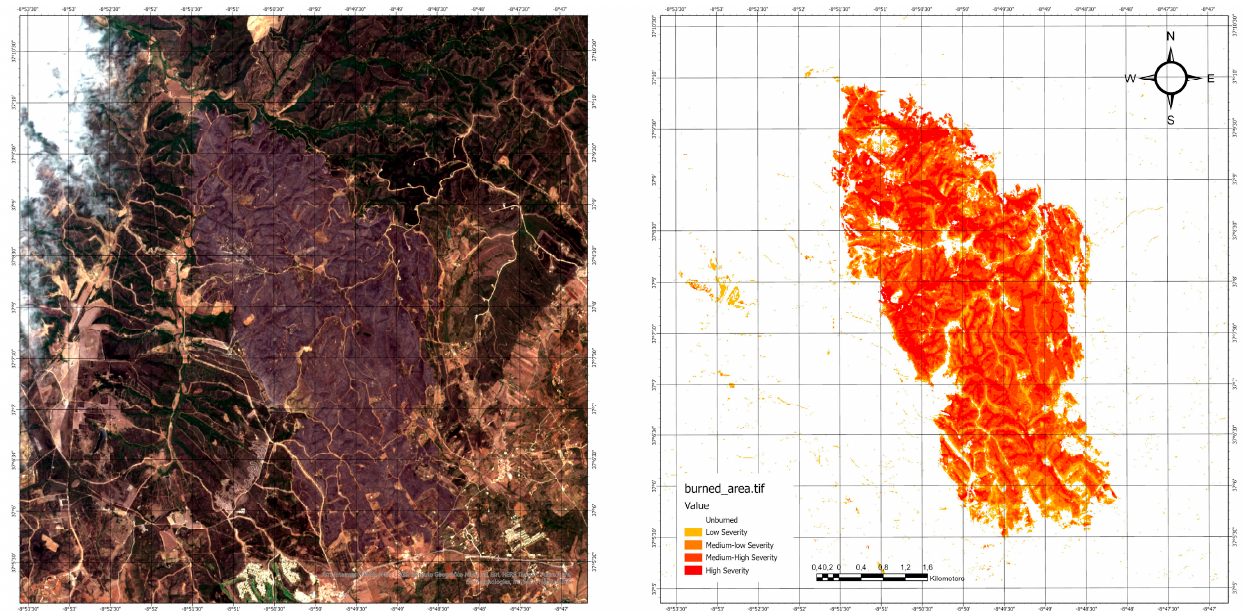
Figure 5. RGB true color representation (using Sentinel-2 bands) of the wider area of Algarve, Portugal ( left ), and the burned area classified into 4 severity classes ( right ).